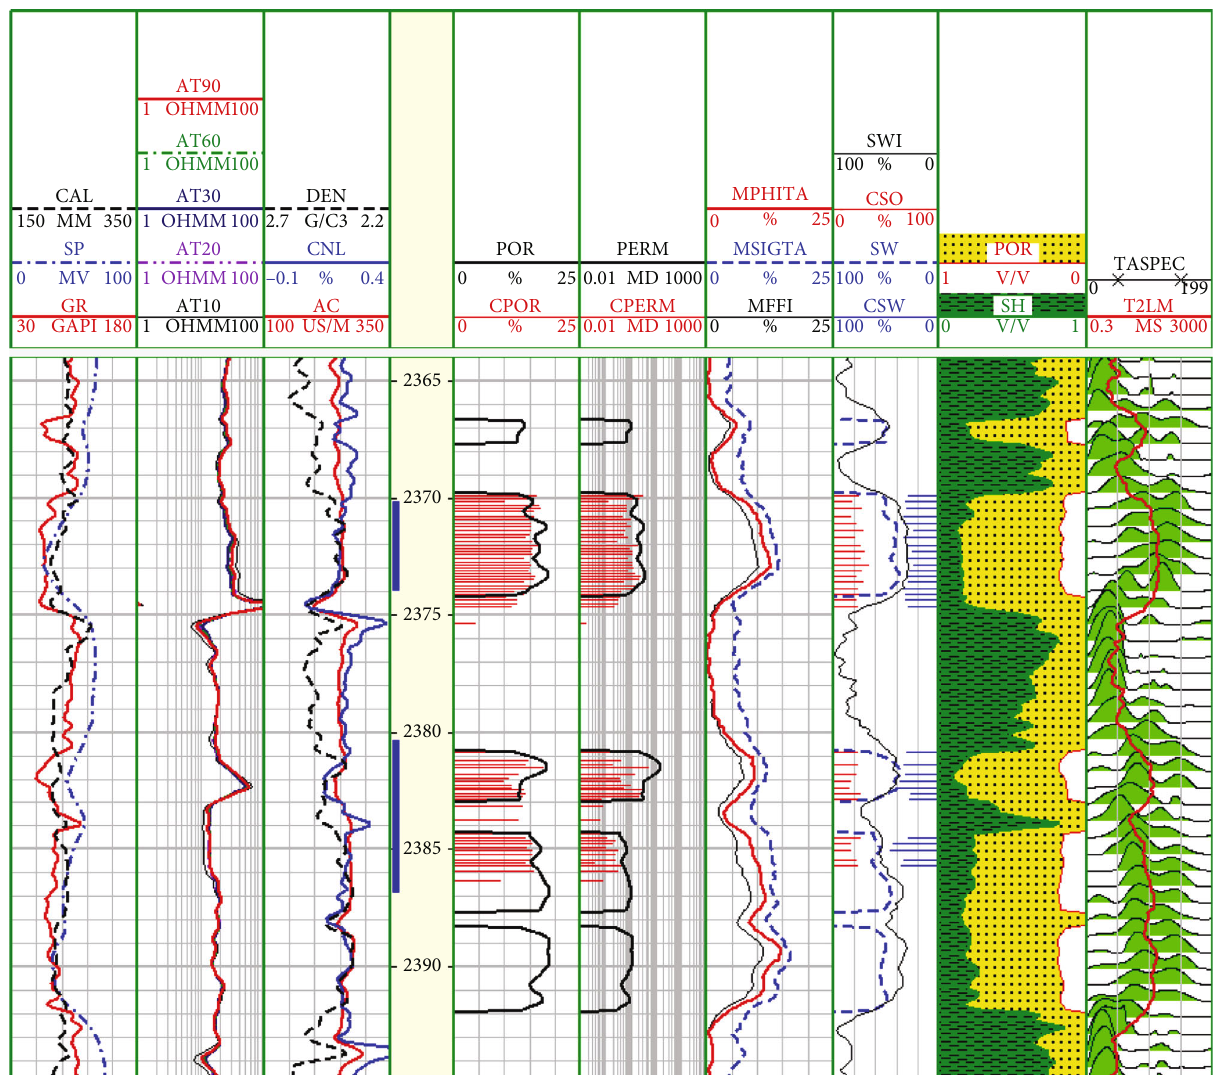
Figure 8: Example of producing di ff erent fl uid types caused by di ff erent irreducible water